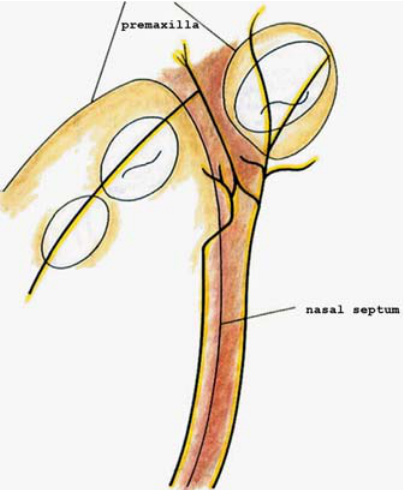
Figure 3- Diagram of nerves and vessels of a unilateral